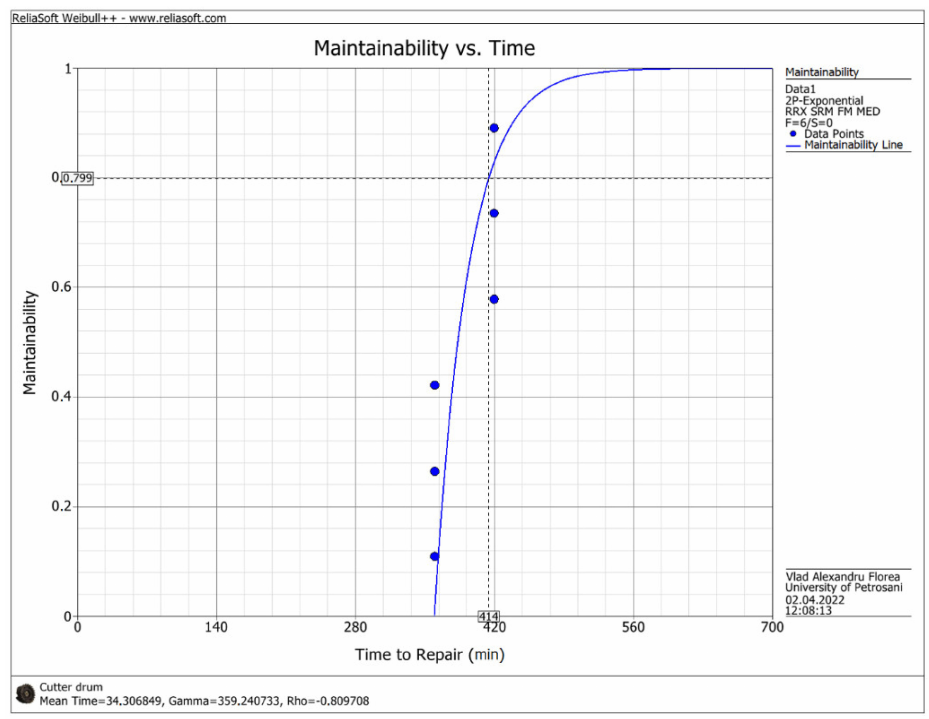
Figure 13. Cleat maintainability values for a 79,9% confidence level for the cutter drum.